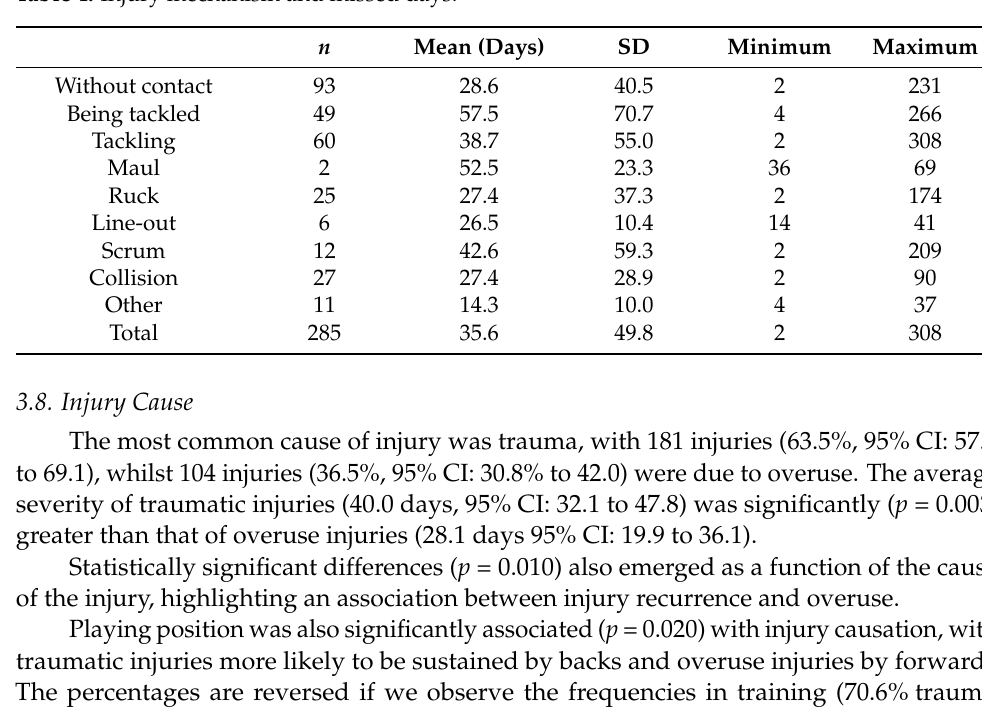
Table 4. Injury mechanism and missed